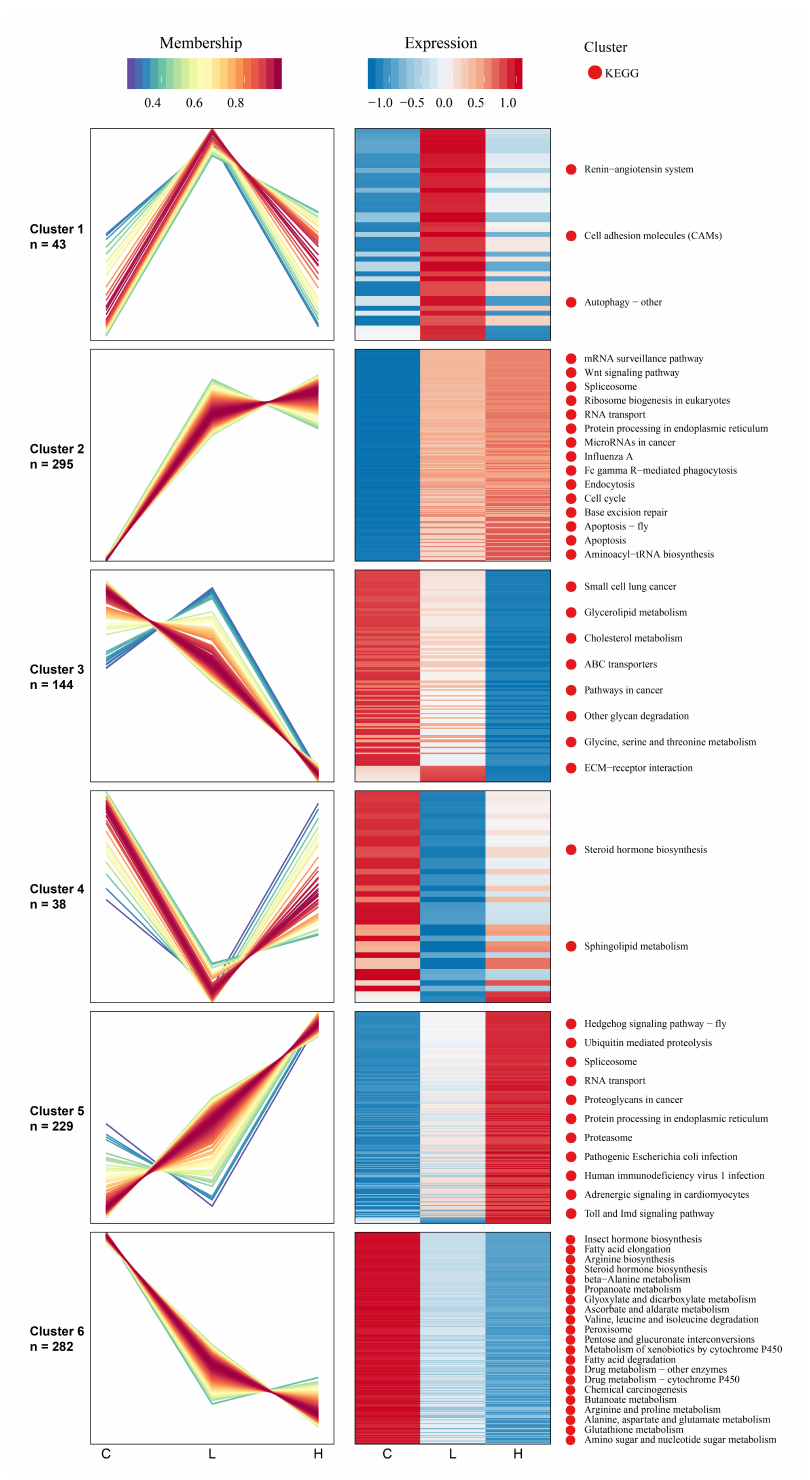
Figure 4. Expression pattern of identified proteins and modification sites via Mfuzz analysis. Mfuzz analysis result of the proteome. The left broken line charts show the protein expression trends in each sample. The horizontal axis indicates different groups, the vertical axis indicates the protein expression amount, and one broken line represents one protein. According to the different trends of the broken lines, they were divided into six different trends through cluster analysis. Heat maps were drawn for the protein sets in each cluster. To further understand the biological processes in which proteins in each cluster are involved, we carried out an enrichment analysis of the KEGG pathway of proteins in each cluster. The first few of the most significant enrichment were listed on the